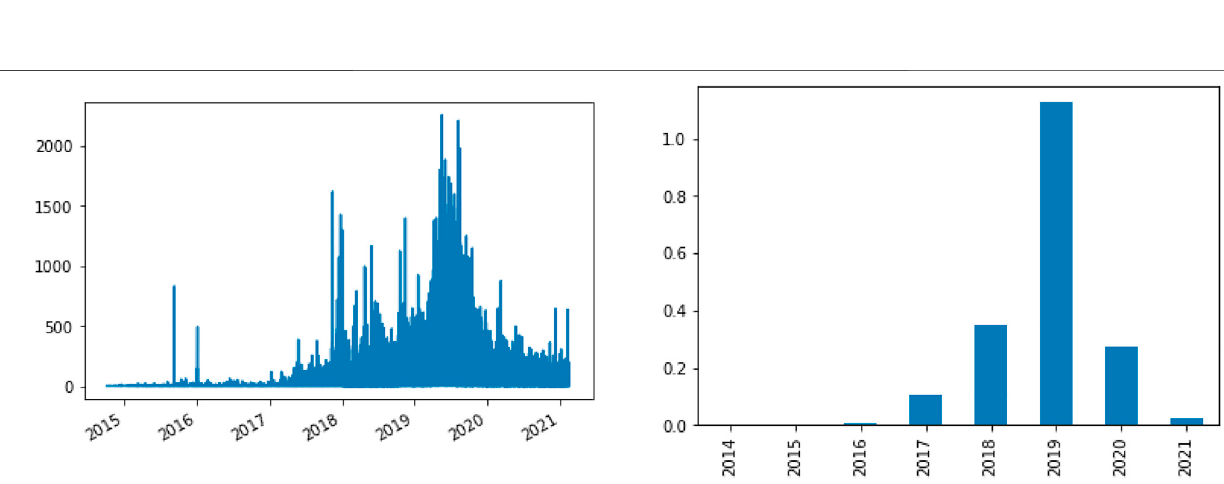
FIGURE 2 | Number of transactions over